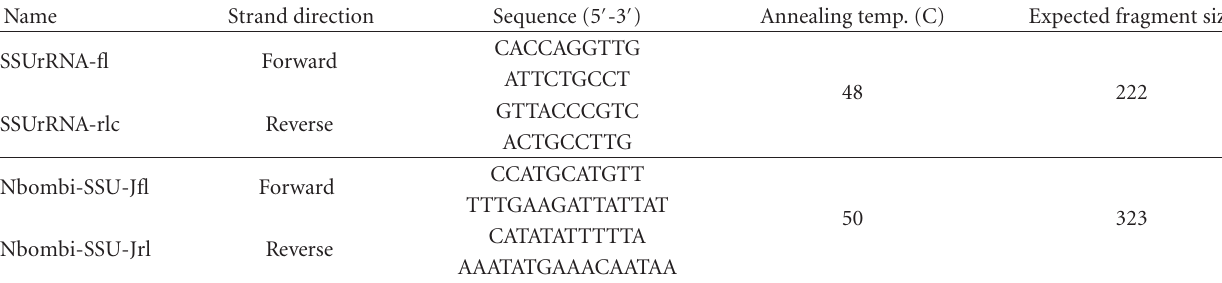
Table 2: Primers used for PCR amplification of ribosomal RNA.